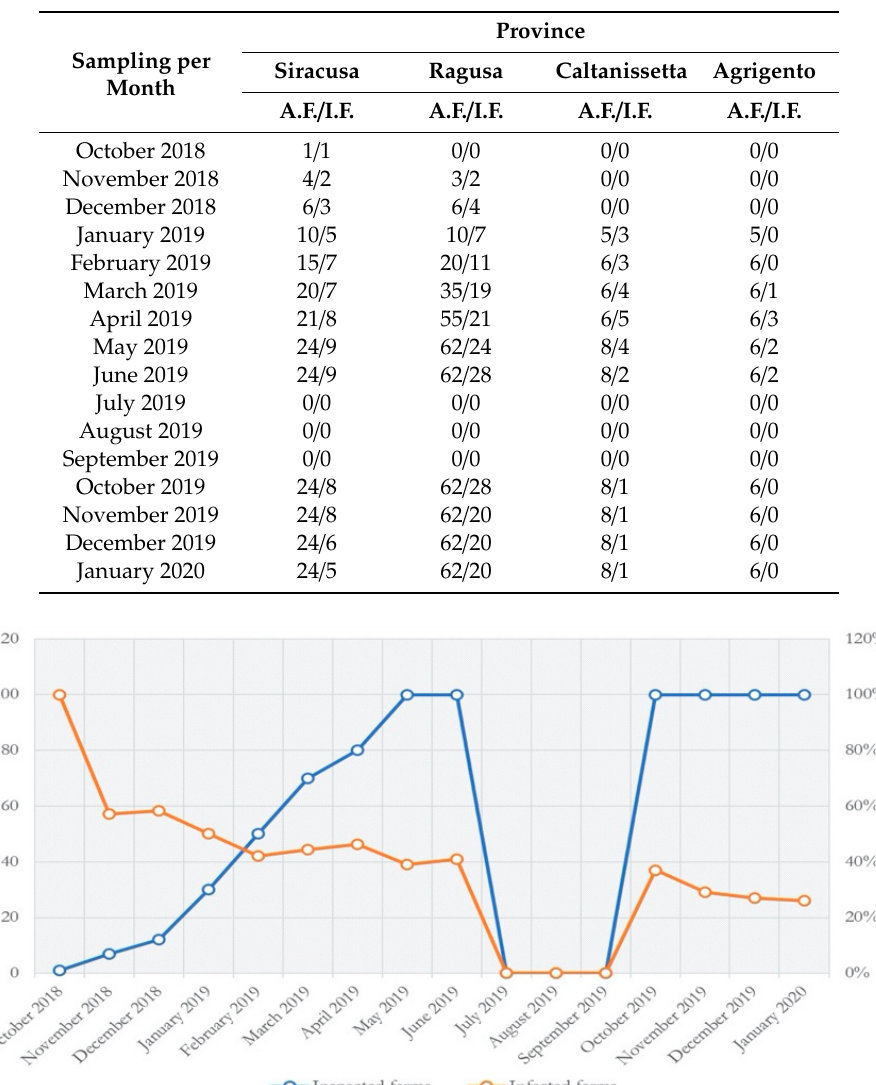
Figure 3. Number of tomato greenhouses inspected per month, during the period October 2018–January 2020 and percentage of ToBRFV-infected